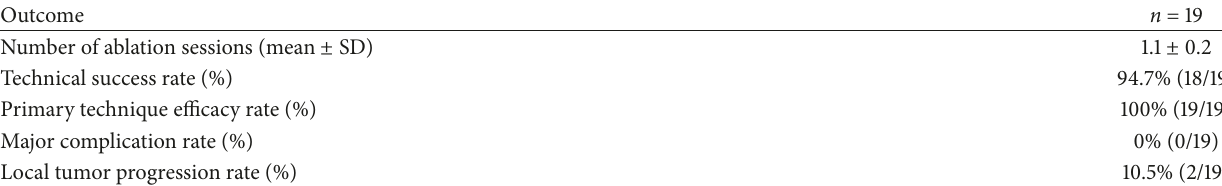
Table 4: Therapeutic outcomes after CEUS-added FI-guided